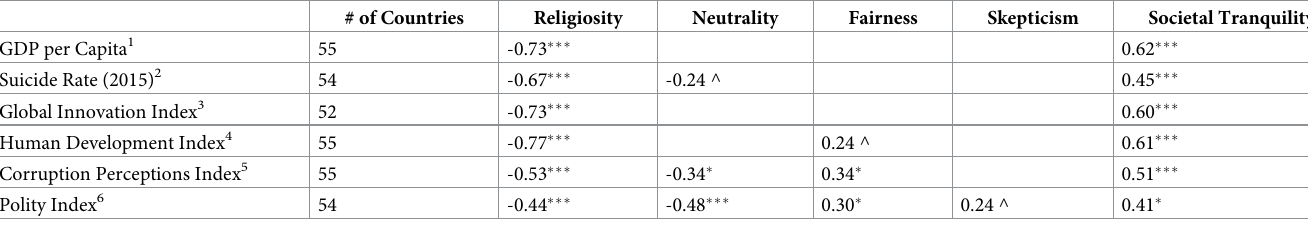
Table 6. Country score correlations with national context variables (Spearman